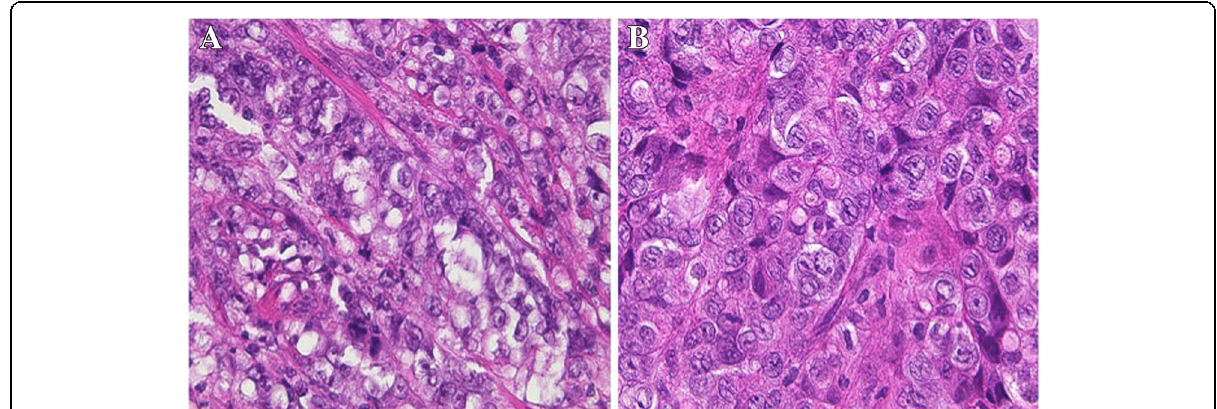
Fig. 3 a Pathological examination of primary gastric cancer revealed poorly differentiated adenocarcinoma (H.E. stain × 400). b Pathological examination of the tumor in left latissimus dorsi muscle revealed poorly differentiated adenocarcinoma, similar to the previously resected gastric cancer (H.E. stain ×